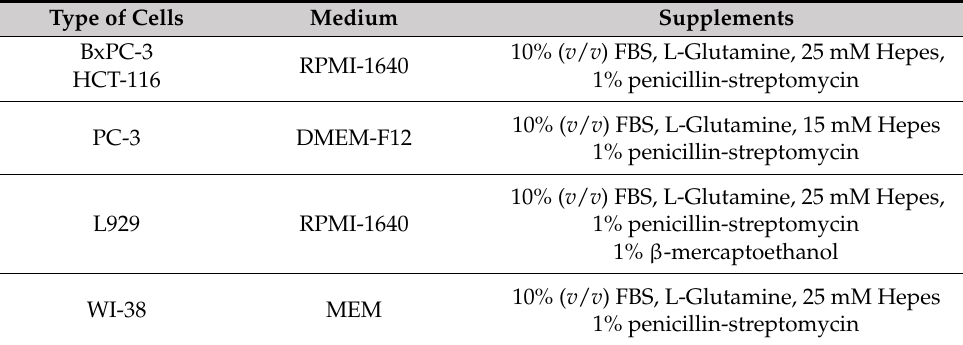
Table 8. Compositions of culture media used to cultivate cells. Type of Cells Medium